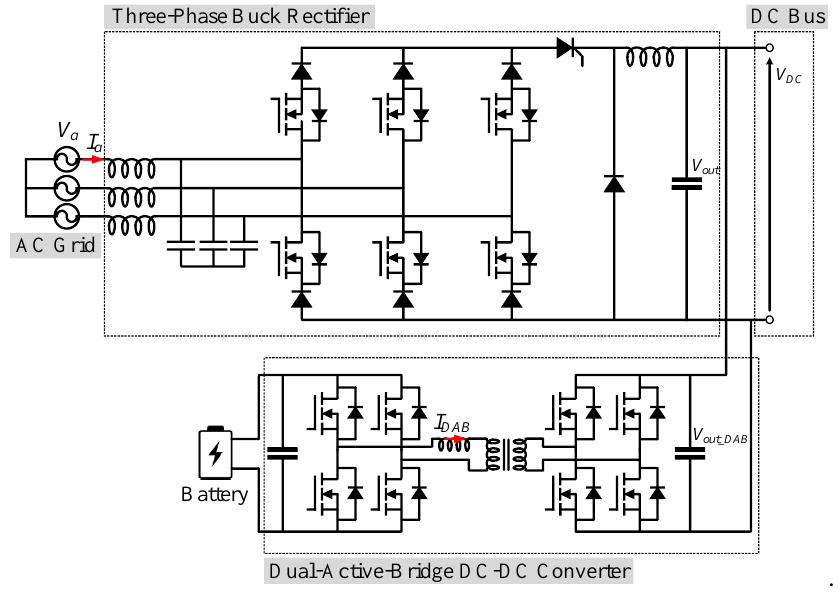
Figure 3. Schematic of the proposed system.